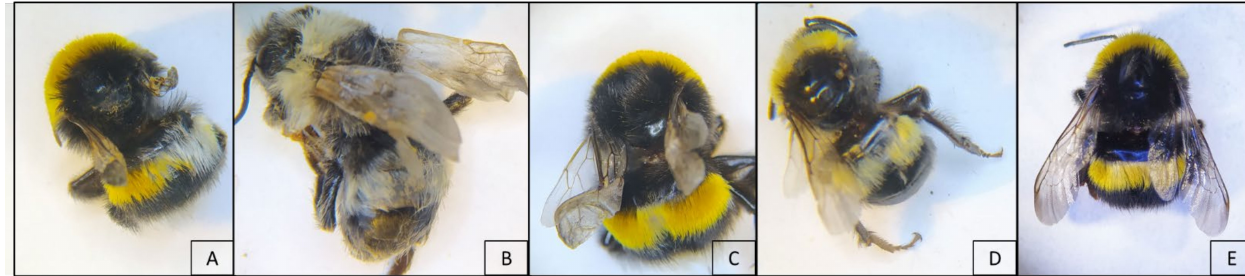
Figure 2. Evidence of several degrees of wing deformities in symptomatic DWV infected Bombus terrestris . Wings of adult bumblebees from the inspected colonies: bilateral ( A , C ) and unilateral ( D ) deformity in workers; bilateral defor- mity in newly hatched male ( B ); asymptomatic worker ( E ). Deformed individuals show yellow and white patches of anomalous pigmentation.